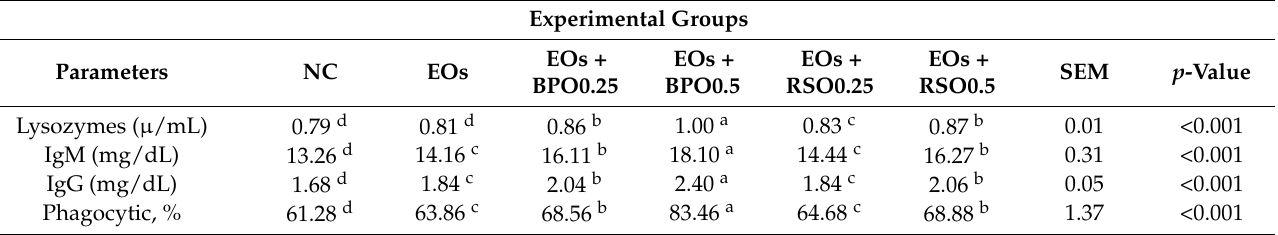
Table 6. Effect of EOs with black pepper oil or radish seeds oil on serum immune parameters in broiler chickens. Experimental